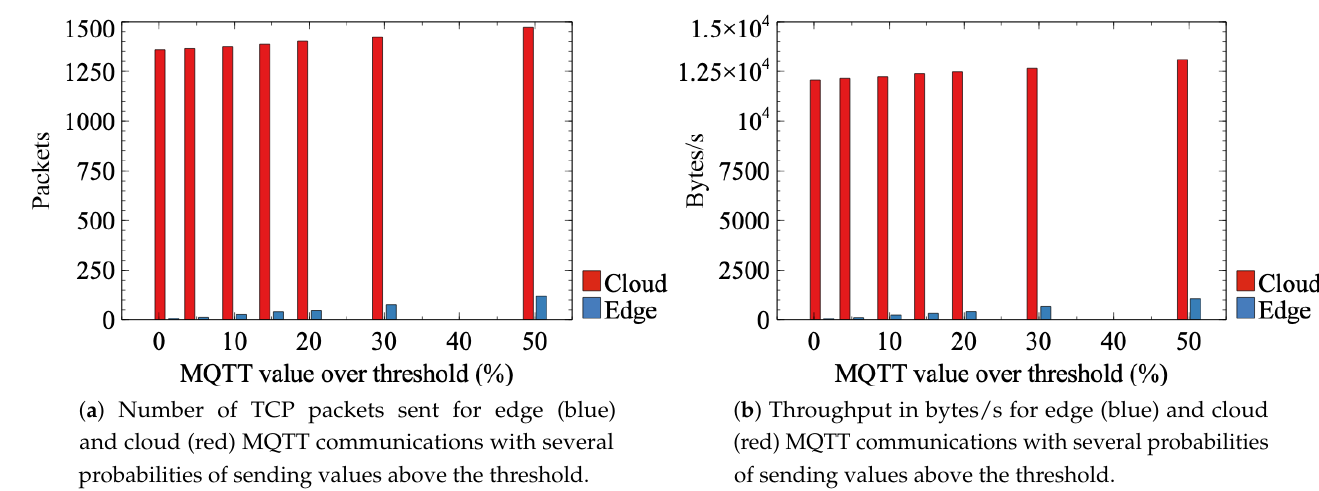
( a ) Number of TCP packets sent for edge (blue) and cloud (red) MQTT communications with several probabilities of sending values above the threshold. Figure 13. Comparison of throughput for edge and cloud MQTT communications with several threshold probabilities. ( a ) Number of TCP packets sent. ( b ) Throughput in